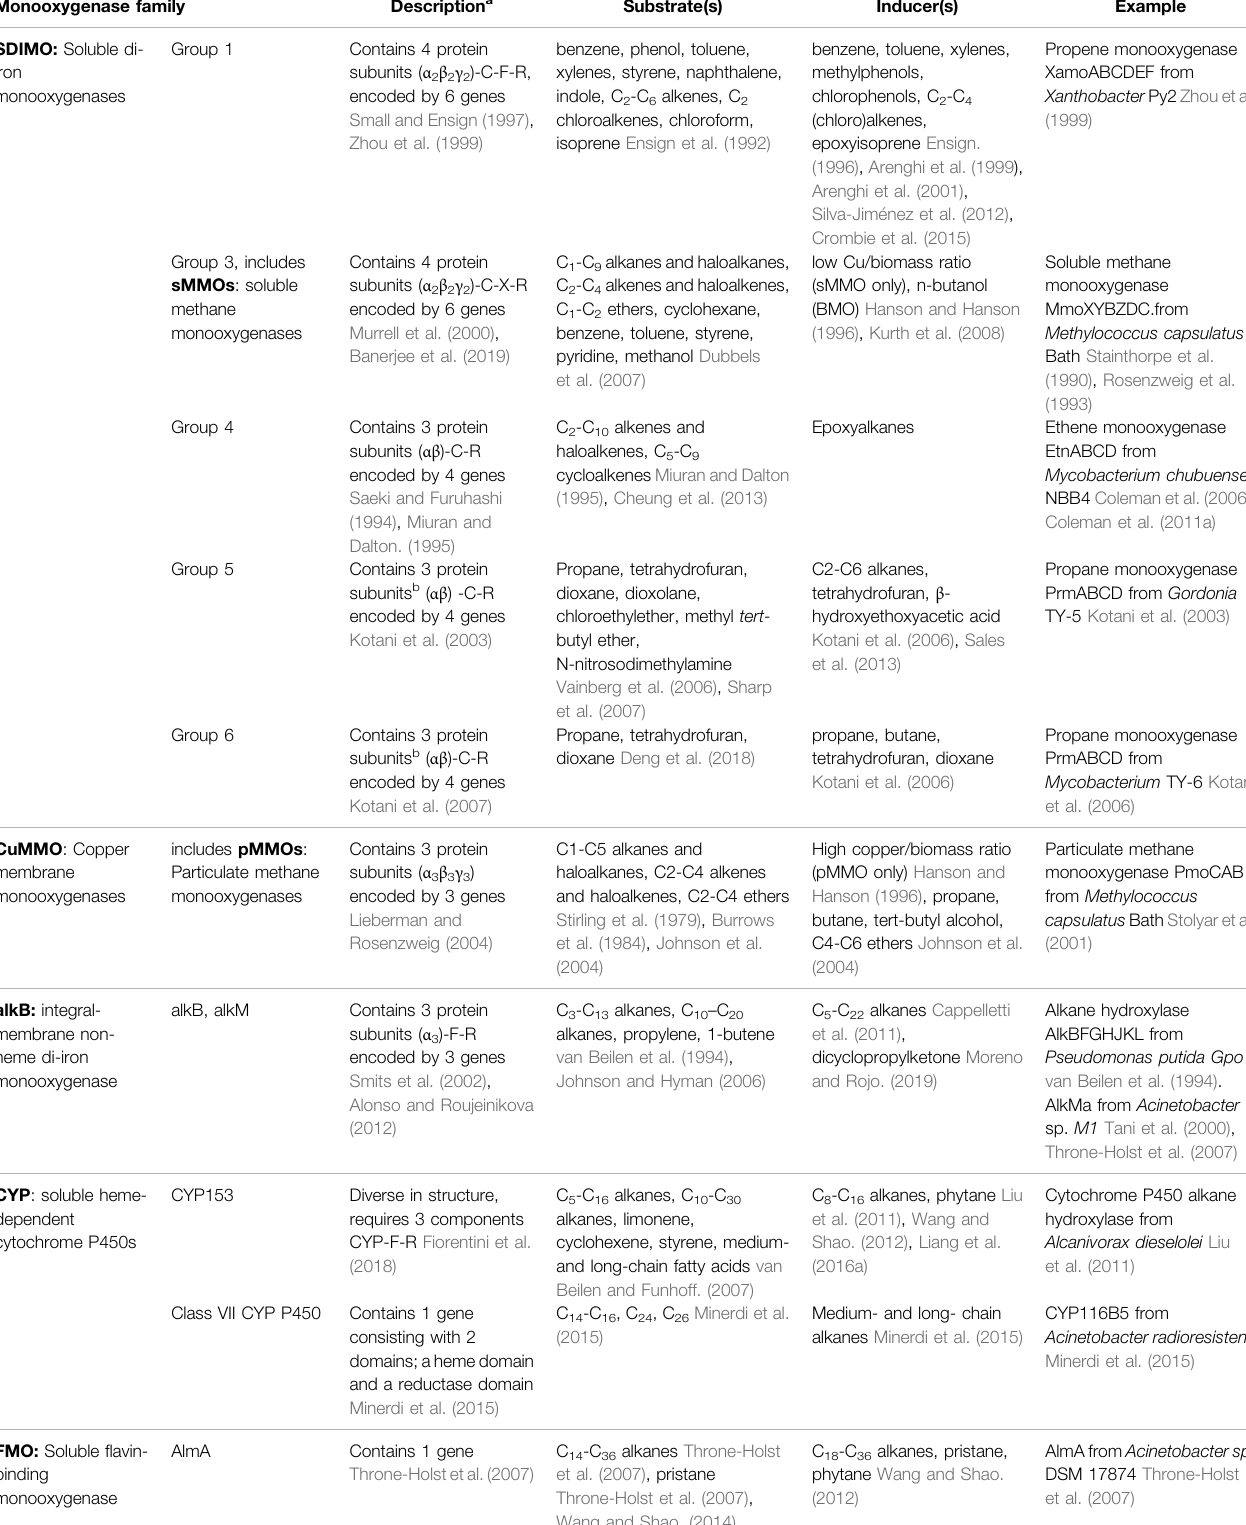
TABLE 1 | Organisation and properties of bacterial monooxygenases involved in aliphatic hydrocarbon